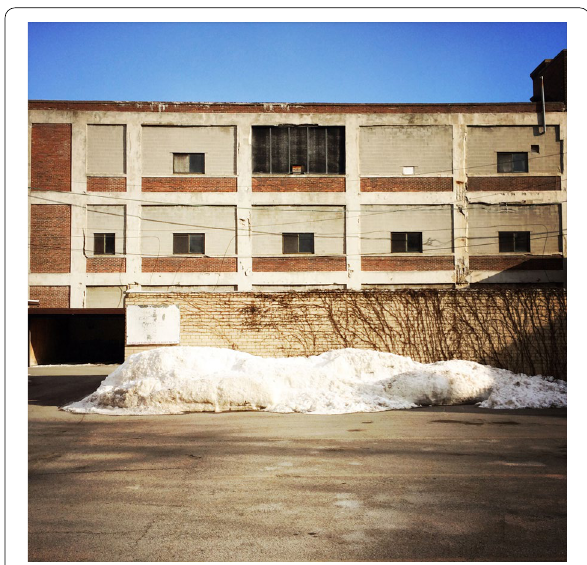
Fig. 9 Industrial building. Buffalo, New York (Photo by author) Fig. 10 Trico Plant No 1. Buffalo, New York (Photo by